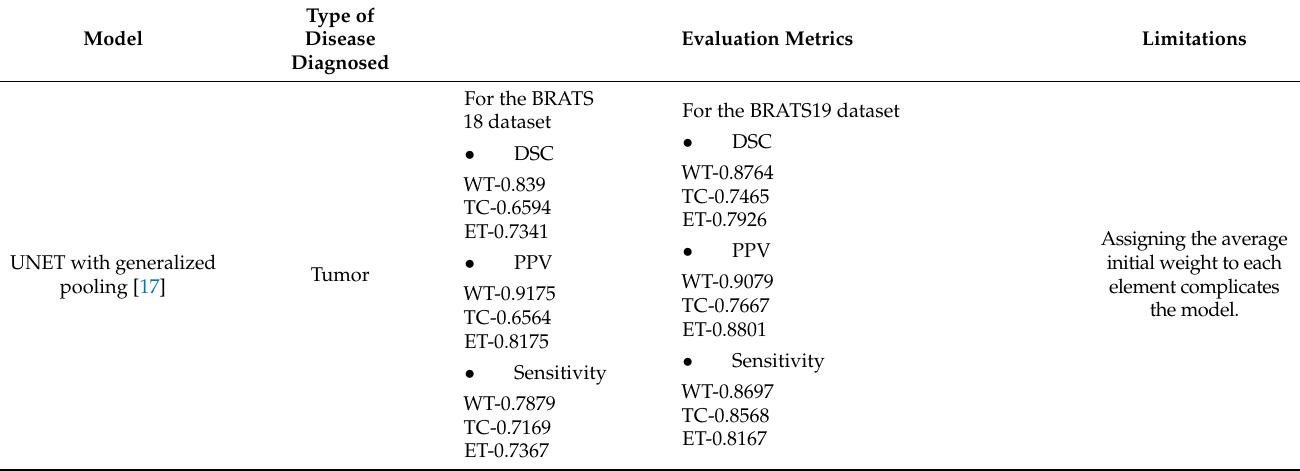
Table 1. Evaluation metrics and limitations of different UNET